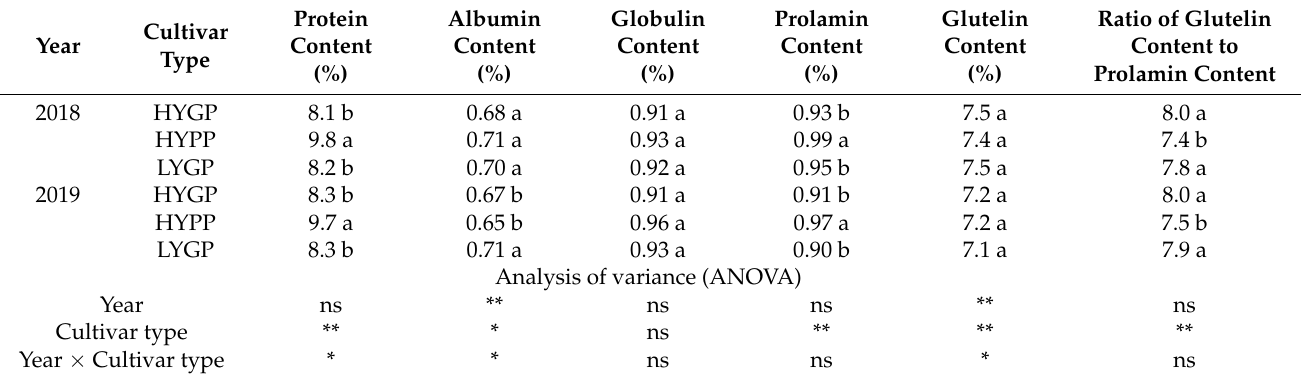
Table 7. Protein content and its composition of rice cultivar types.